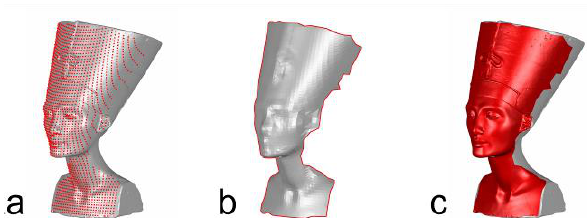
Figure 1. Simulated point cloud (a), triangulated point cloud (b) and projection of the boundary onto the object of interest (c).